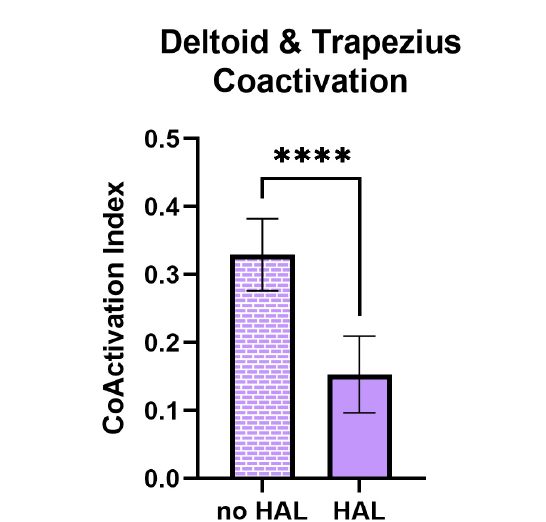
FIGURE9 Averaged adjustment ratio for the first three sessions, the three sessions preceding the reaching of the 90 degrees ROM, and the last three sessions of patients, and of healthy